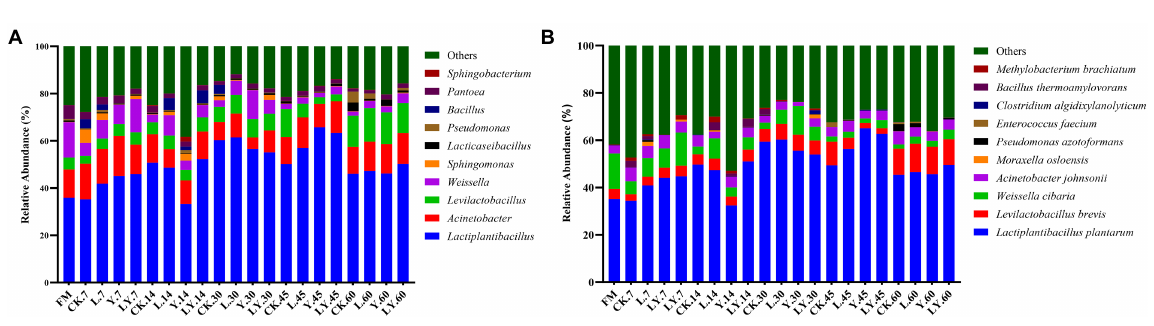
FIGURE. 1 The relative abundance of dominant genera (A) and species (B) in cellulase-treated Pennisetum sinese (CTPS) after anaerobic storage. CK, control; L, Lentilactobacillus buchneri ; Y, yeast; LY, a mixture of L. buchneri and